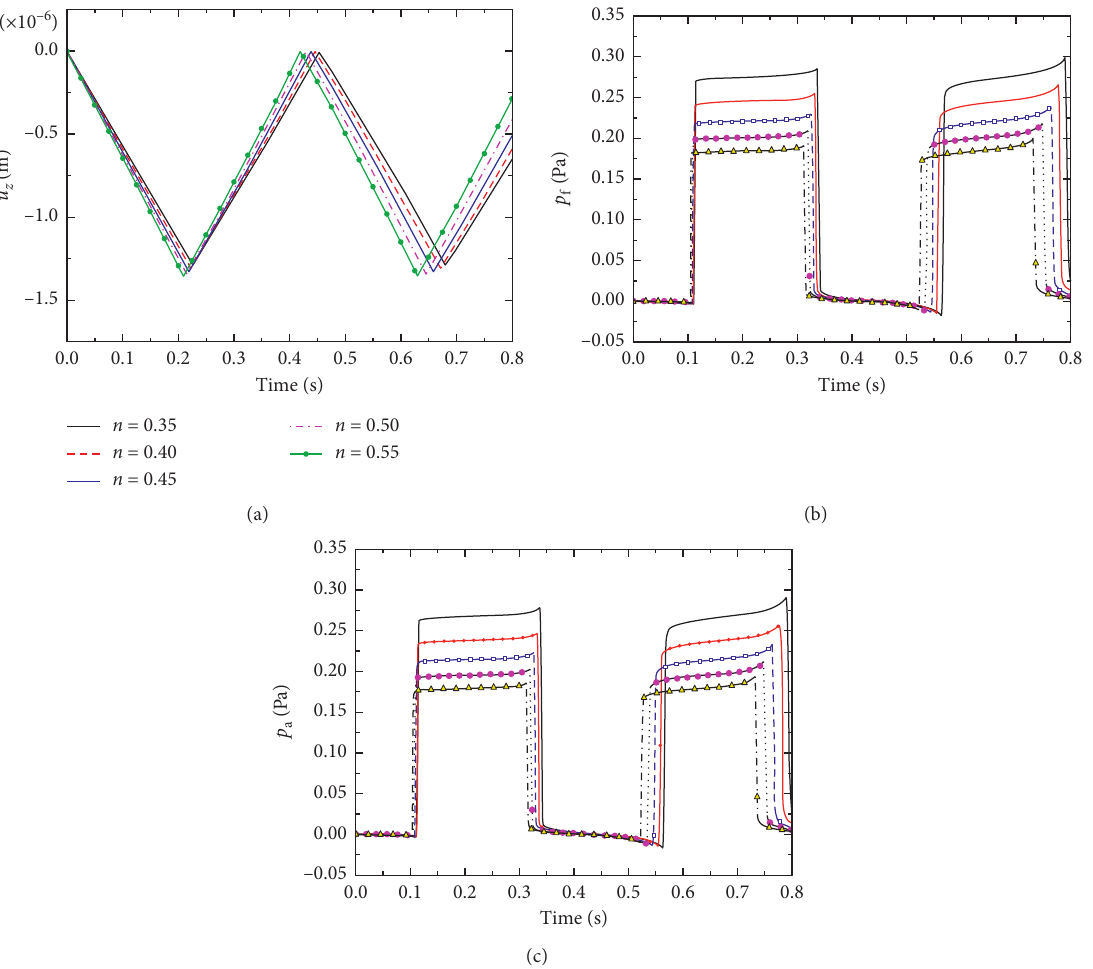
Figure 7: Distributions of the displacement of solid particles u using different porosity values ( n � 0.35 to 0.55). (a) u z . (b) p f . (c) p a